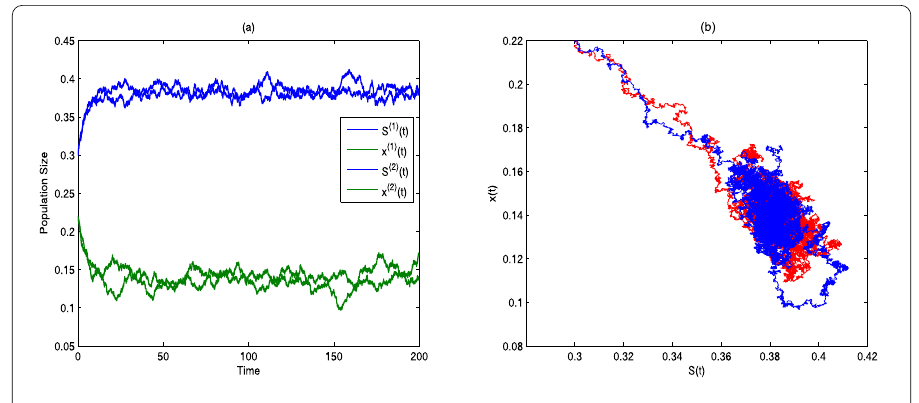
Figure 4 The time series and portrait phase of model (4.2) when α = 0.3 ( S (1) ( t ) and S (2) ( t ) are two sample paths about S ( t ), x (1) ( t ) and x (2) ( t ) are two sample paths about x ( t ).) ( a ) represents the time series of S ( t ) and x ( t ); ( b ) represents the portrait phase.